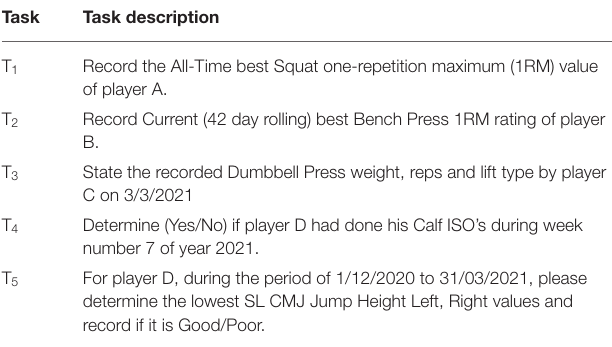
TABLE 1 | Information quality assessment and cognitive walkthrough participant characteristics.